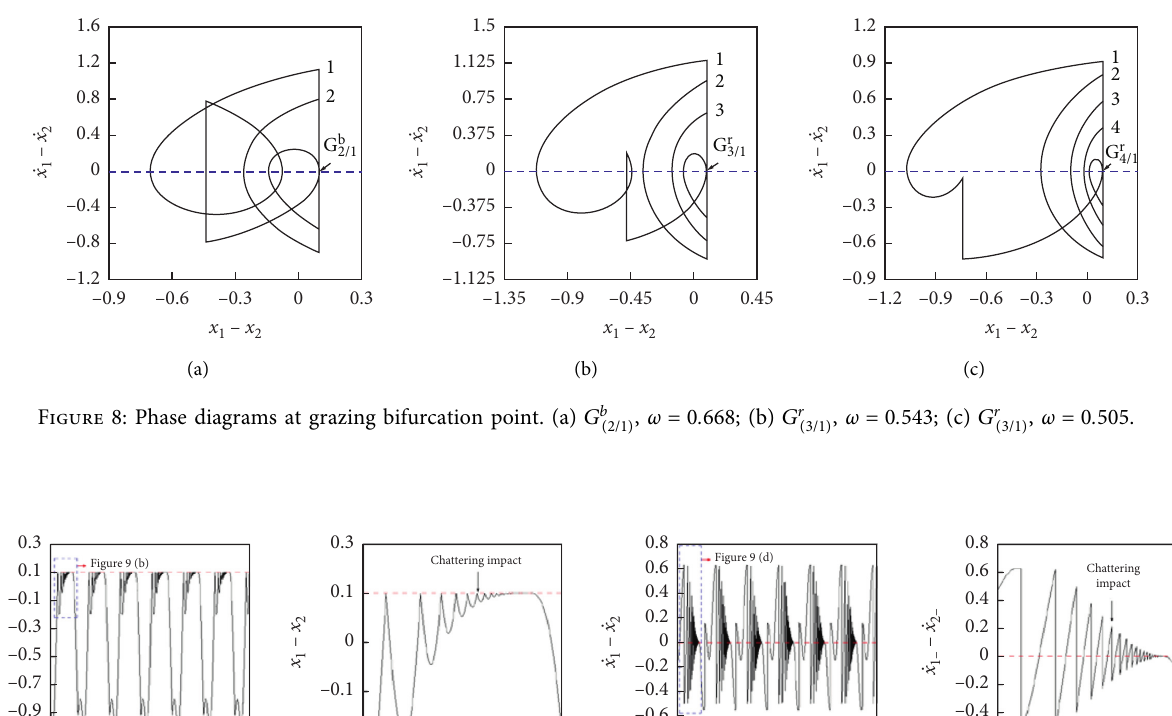
Figure 7: Bifurcation diagrams of the low-frequency region of the system at constraint A bifurcation diagram.